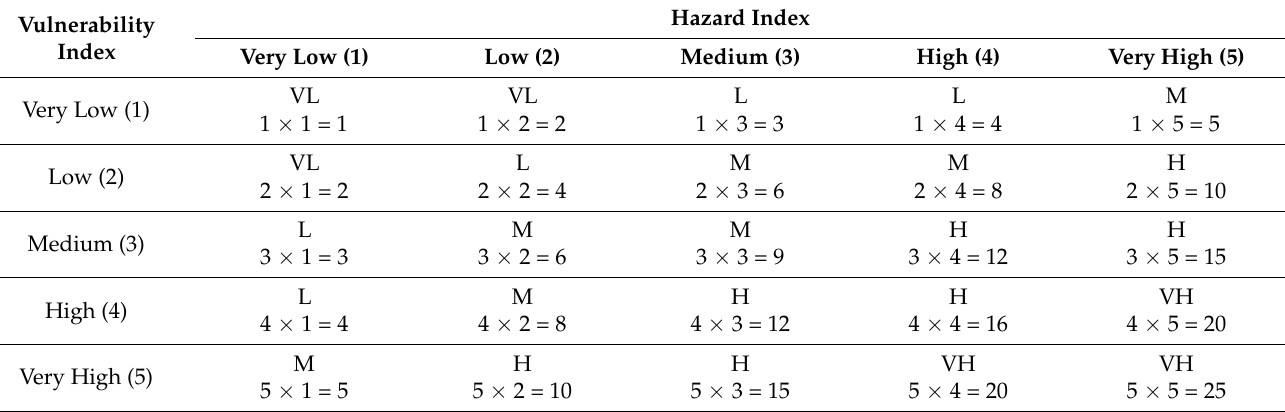
Table 4. Flood risk